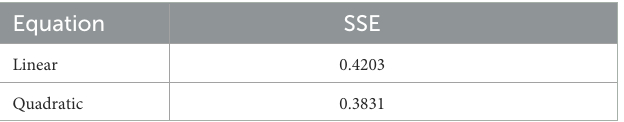
TABLE 4 Results of the empirical fit between linear and quadratic model specifications using sum of squared errors (SSE) with quadratic specification showing less